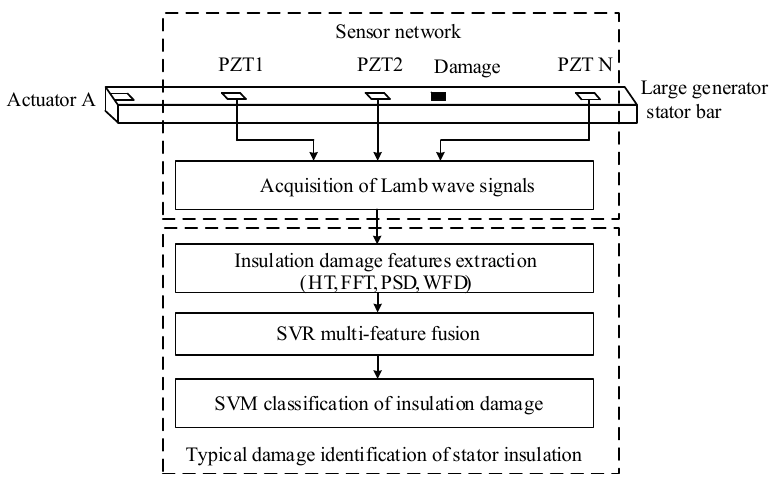
Figure 1. Schematic diagram of stator insulation damage identification using Lamb wave.